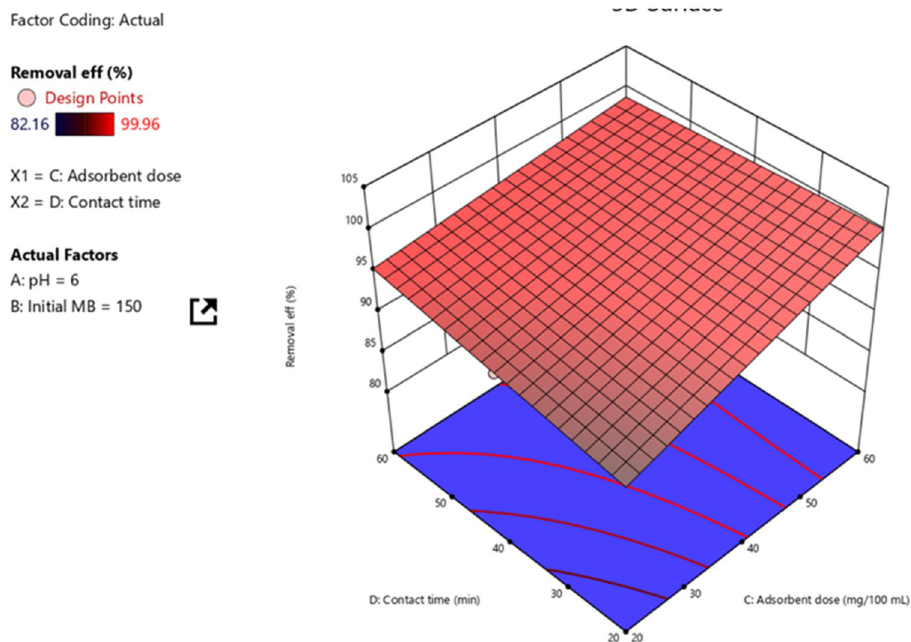
Figure 7. Interaction effect of adsorbent dosage and contact